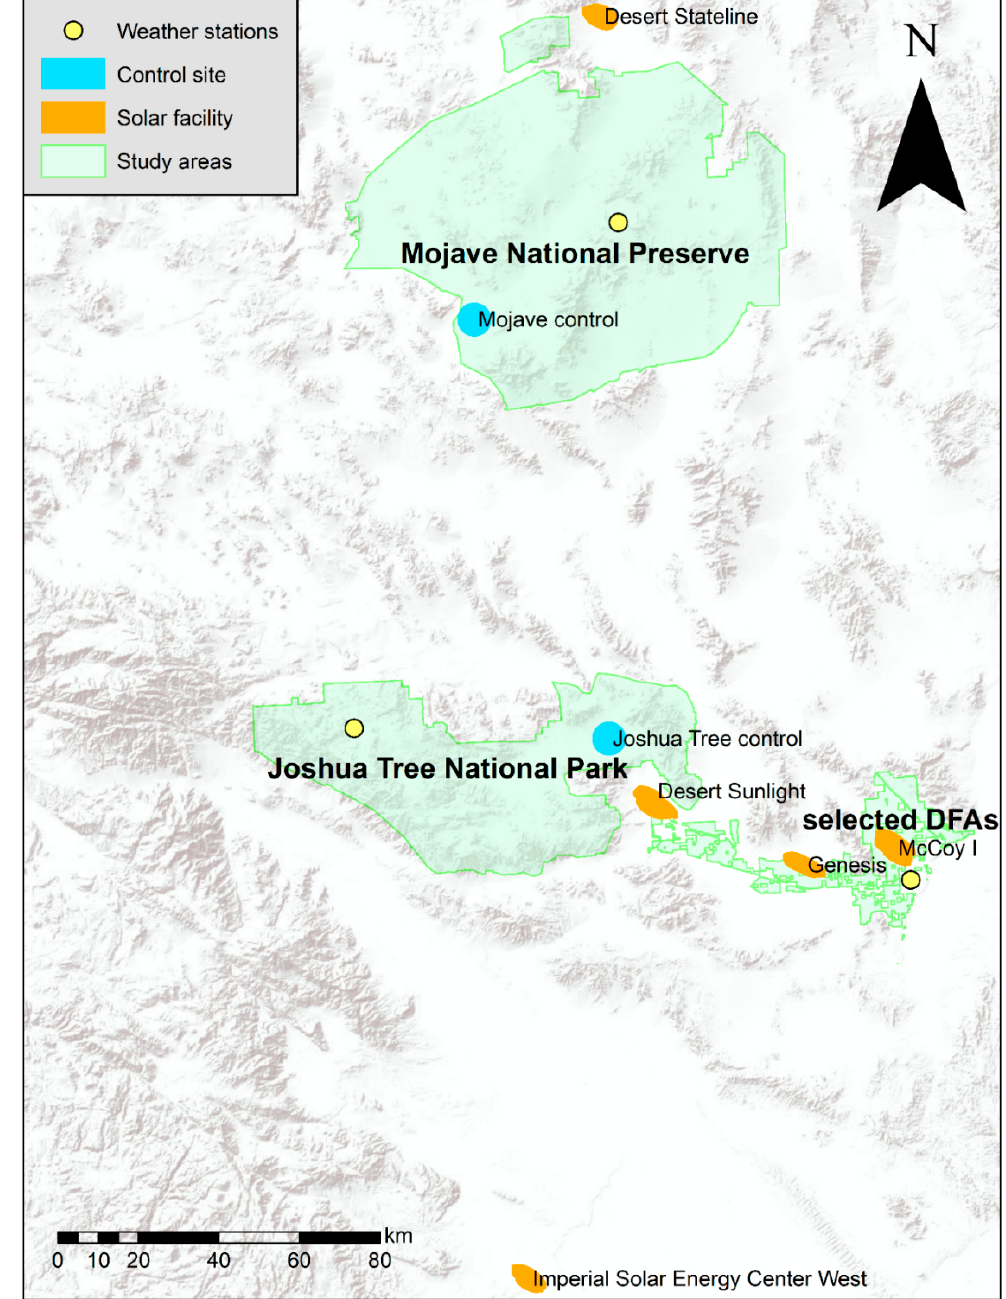
Figure 1. Location of study areas in the Mojave and Lower Colorado Deserts of southern California.